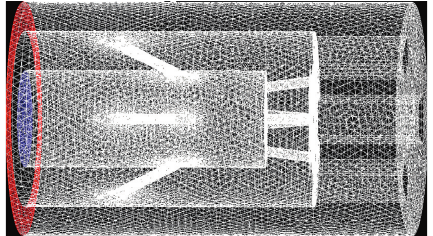
Figure 3: Grid division of the computing